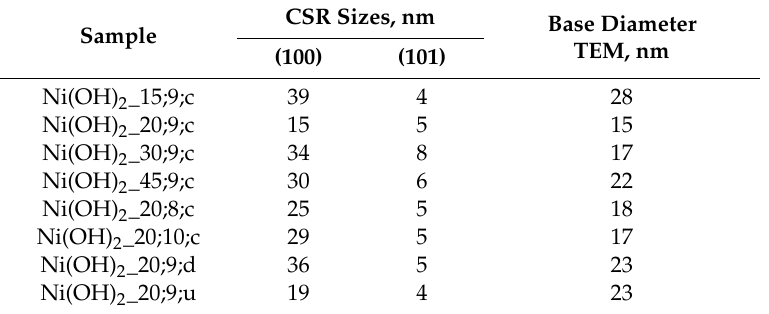
Table 4. CSR sizes and particle sizes calculated from the electron microscopy results.